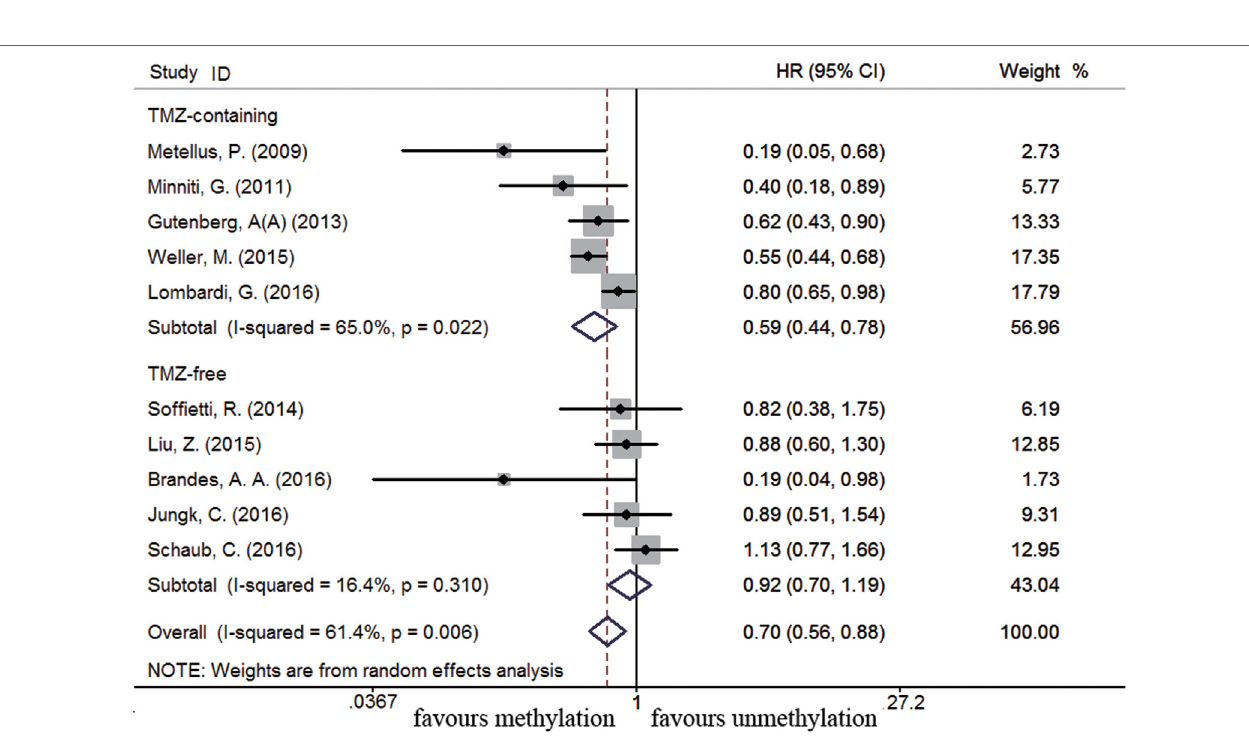
FiGURe 9 | Calculated HR and 95% CIs for the relationship between methylation and OS benefit from TMZ-containing or TMZ-free therapy in recurrent GBM patients (methylated vs. unmethylated patients).